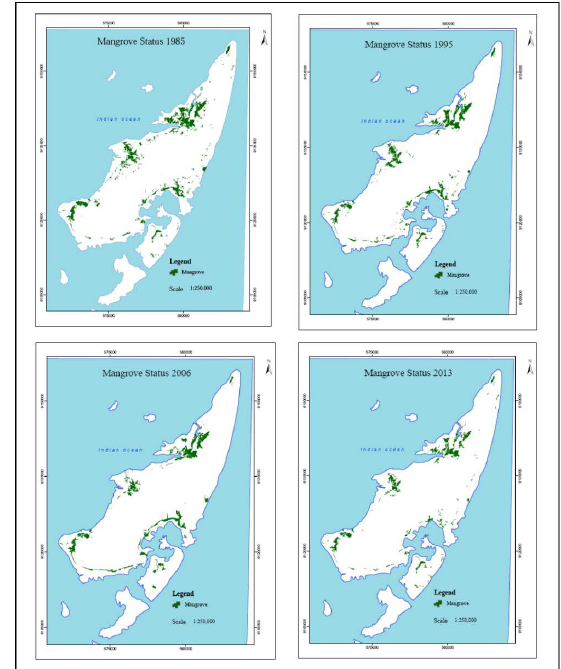
Figure 6. Spatial distribution of mangroves in Mafia Island in